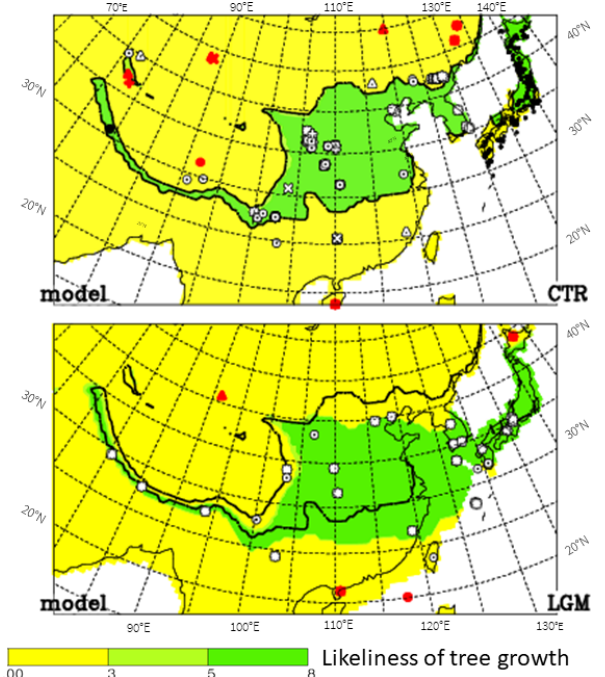
Figure 8. Same as Fig. 6 using model data without downscaling. The Yellow Sea is shown as land in the LGM.